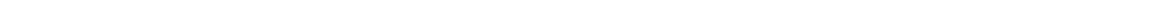
Fig. 6 KIF20A co-localizes with growing microtubules on Golgi membranes. a HeLa cells were incubated for 45 min at 4 °C to promote microtubule depolymerization (without affecting the Golgi morphology) and then incubated for 3 min at RT to allow microtubule repolymerization. Staining of endogenous KIF20A (green) and β -tubulin (red) in HeLa cells indicates a partial co-localization of KIF20A with growing microtubules from Golgi membranes (see higher magni fi cations (boxes) on the bottom). Line pro fi les of the KIF20A (green) and the β -tubulin (red) fl uorescence intensities (arbitrary units) along the white dashed line. Bar, 10 µ m. b Staining of GFP-RAB6 (green), MLC-mCherry (red), and endogenous GCC185 (blue) in HeLa cells indicates a partial co-localization of the three proteins on dotted structures at the Golgi complex (see higher magni fi cations (boxes) on the bottom). Line pro fi les of the GFP-RAB6 (green), the MLC-mCherry (red), and the GCC185 (blue) fl uorescence intensities (arbitrary units) along the white dashed line. Bar, 10 µ m. c Schematic of the sequence of events that can be envisioned for the generation of fi ssion hotspots at the TGN. (1) RAB6 diffuses on Golgi/TGN membranes. (2) RAB6 participates in the recruitment and stabilization of KIF20A. When bound to KIF20A, RAB6 diffusion is decreased allowing the localization and anchoring of RAB6 molecules to sites of growing Golgi-associated microtubules. (3) Myosin II is recruited by KIF20A and RAB6. Either a complex between RAB6 and KIF20A is required for Myosin II recruitment, or KIF20A acts alone. Myosin II can be recruited by the KIF20A- RBD-529-665 domain in complex or not with RAB6 or through the 796 – 887 domain. (4) KIF20A, RAB6, and Myosin II, in association with actin fi laments and microtubules, de fi ne a Golgi fi ssion hotspot. There are around six hotspots per Golgi. (5) Myosin II and actin then drive the fi ssion of RAB6-positive transport carriers from Golgi/TGN membranes. RAB6-positive vesicles are then transported along microtubules to the plasma membrane thanks to